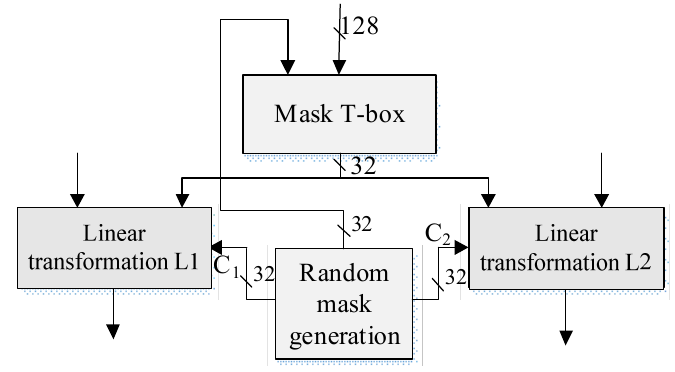
Figure 1. Schematic diagram of SM4 module resistant to Power Analysis.